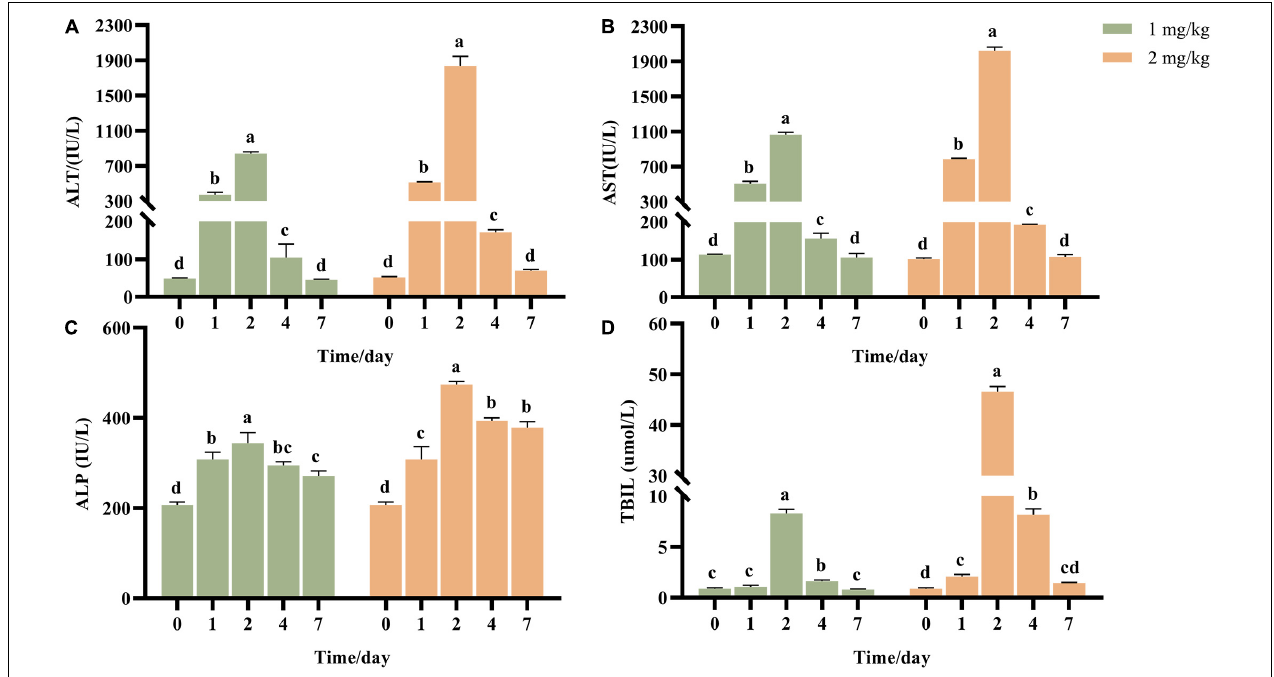
FIGURE 2 | Effect of AFB 1 on serum liver function indicators in rats. (A) Serum alanine aminotransferase (ALT), (B) aspartate aminotransferase (AST), (C) alkaline phosphatase (ALP) activities, and (D) total bilirubin (TBIL) were measured. 0: serum samples before ASAE; 1, 2, 4 and 7: serum samples on 1st, 2nd, 4th and 7th days after ASAE.